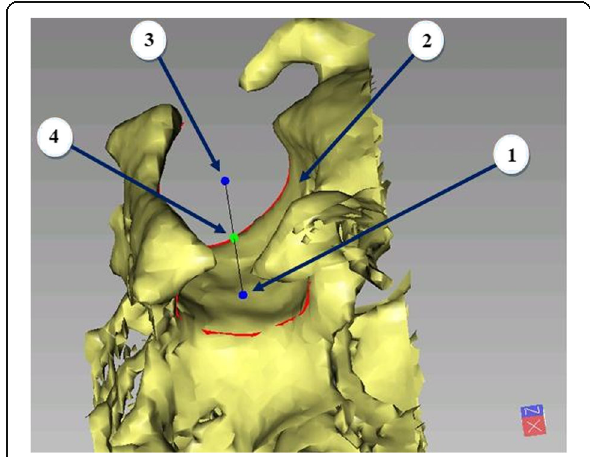
Fig. 1 Constructing R-and L-Sella: 1, R-Sella; 2, Hypophyseal fossa; 3, L-Sella; 4, C-Sella. Red line: Sella border